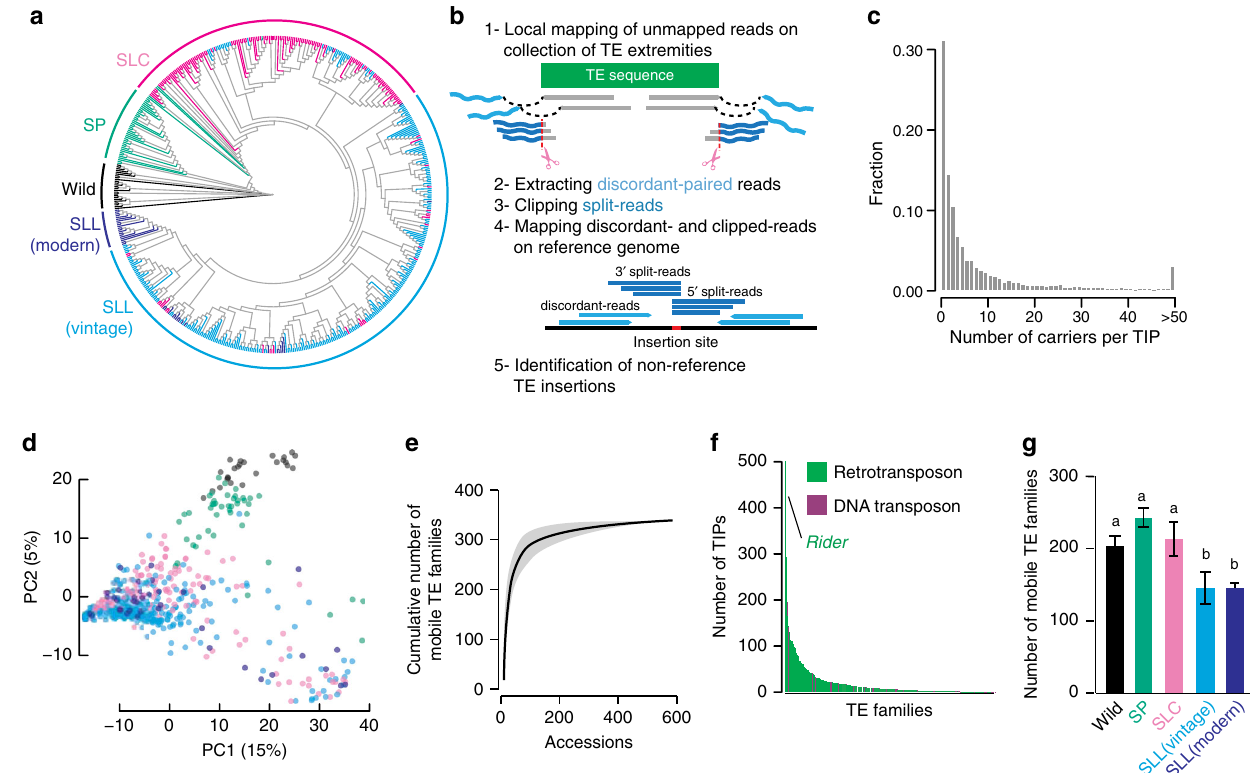
Fig. 1 The tomato mobilome. a Phylogeny of the 602 tomato accessions analyzed, including wild tomato relatives (Wild), wild tomatoes ( S. pimpinellifolium , SP), early domesticated tomatoes ( S. lycopersicum cerasiforme , SLC), and cultivated tomatoes ( S. lycopersicum lycopersicum vintage and modern, SLL). b Schematic representation of the SPLITREADER bioinformatics pipeline used to identify TE insertion polymorphisms (TIPs) using split- and discordant reads. c Distribution frequency of allele counts for TIPs. d Principal component analysis based on TIPs. Colors represent tomato groups as indicated in ( a ). e Cumulative plot of the number of mobile TE families detected with increasing numbers of accessions. Shaded bands represent ±95% CI. f Number of detected TIPs per TE family. g Number of mobile TE families detected in each tomato group. Data are mean ±95% CI obtained by 100 bootstraps, and statistical signi fi cance for differences were obtained by a randomization test. Source data of Fig. 1a, f are provided as a Source Data fi